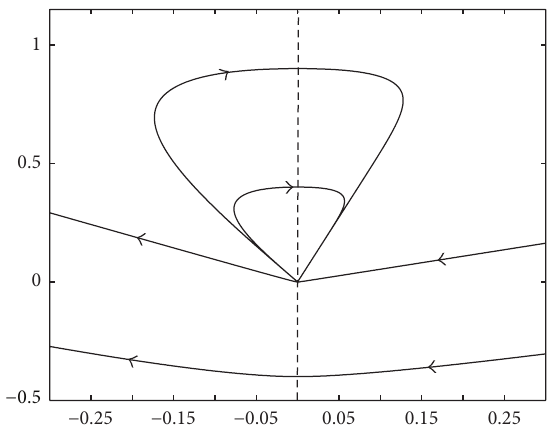
Figure 2: Degenerate homoclinic orbits for the node-node system.